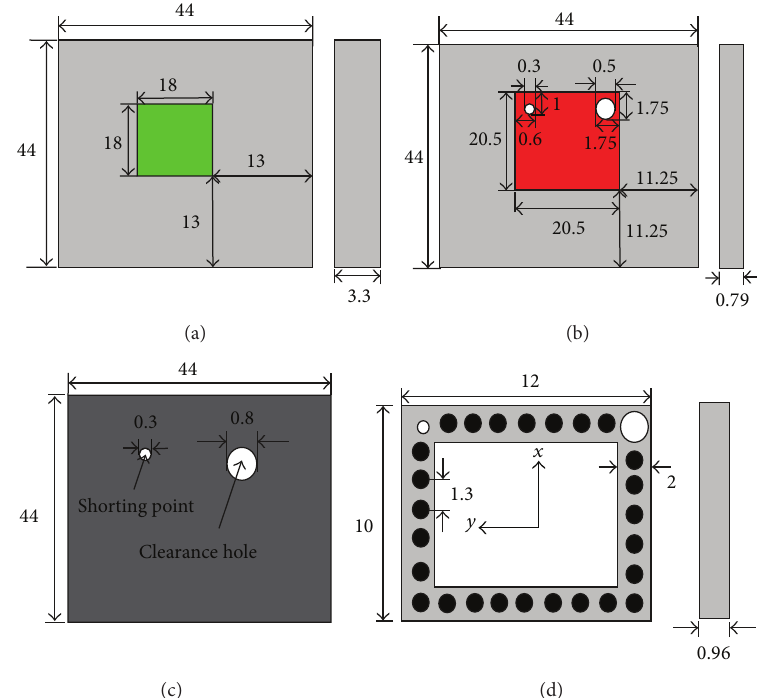
Figure 2: Design parameters of each layer, (a) upper patch layer, (b) lower patch layer, (c) antenna ground layer, and (d) package layer with complete grounded vias. The unit is in mm.